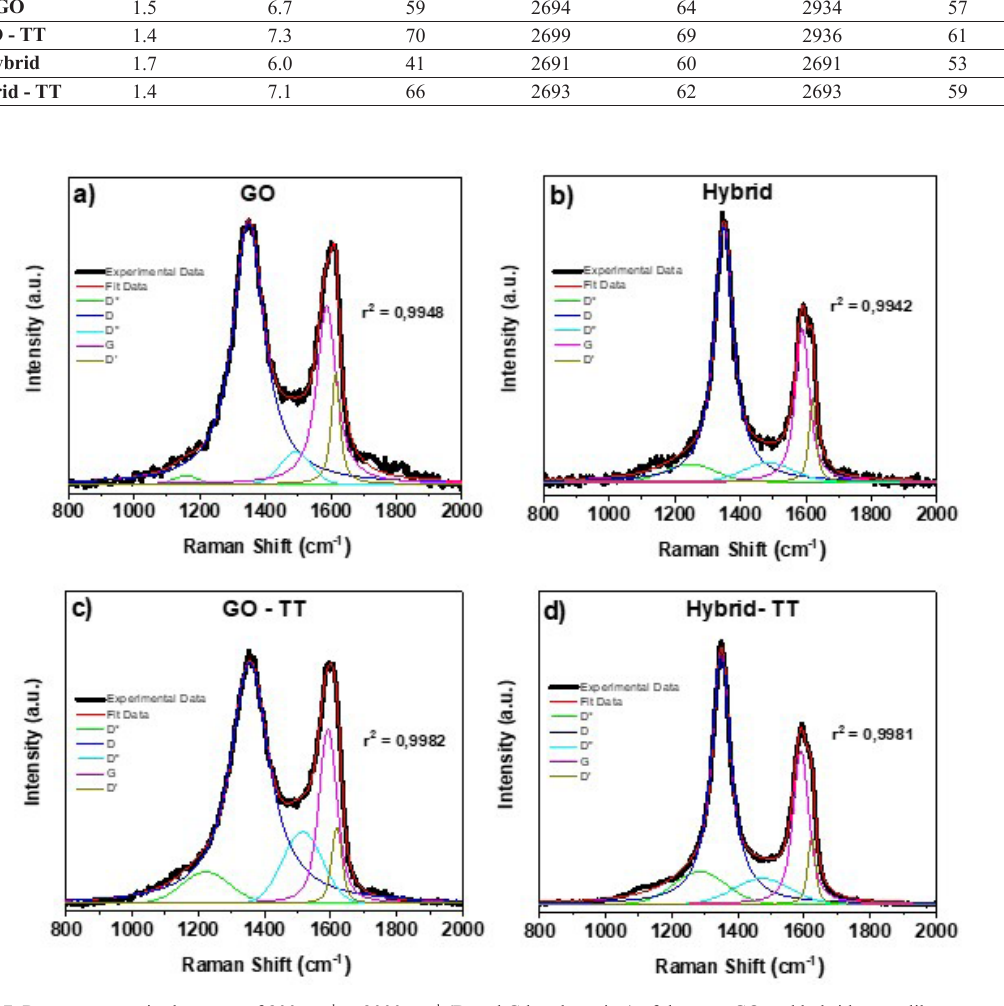
Figure 7. Raman spectra in the range of 800 cm -1 to 2000 cm -1 (D and G bands region) of the pure GO and hybrid paper-likes untreated ( a-b ) and treated thermally (TT) ( c-d ). The five functions (D*,D, D″, G, and D′ bands) were adjusted for all the samples according to the protocol available in the literature 40,41 .